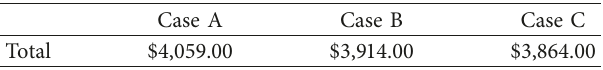
Table 3: Summary of portal labour costs. Table 4: Summary of total portal frames